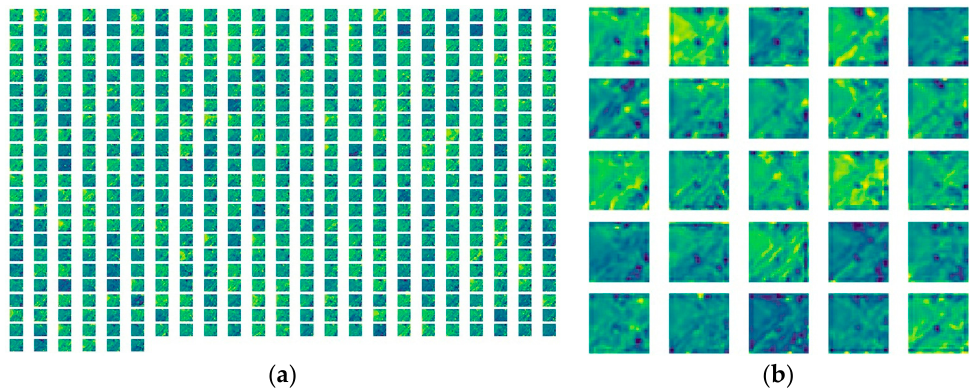
Figure 4. Feature visualization of small objects. ( a ) 256 channels’ features. ( b ) first 30 features.